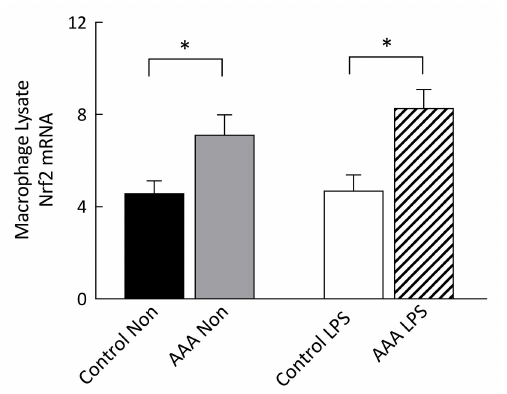
Figure 3. Comparison of relative levels of Nrf2 transcripts in macrophages from control participants and patients with AAA. Nrf2 mRNA levels, measured by real time qPCR, were normalized to GAPDH. Nrf2 mRNA was significantly increased in both non-stimulated and 24 h LPS-stimulated ( n = 8) AAA macrophages compared to control ( n = 9). * p <